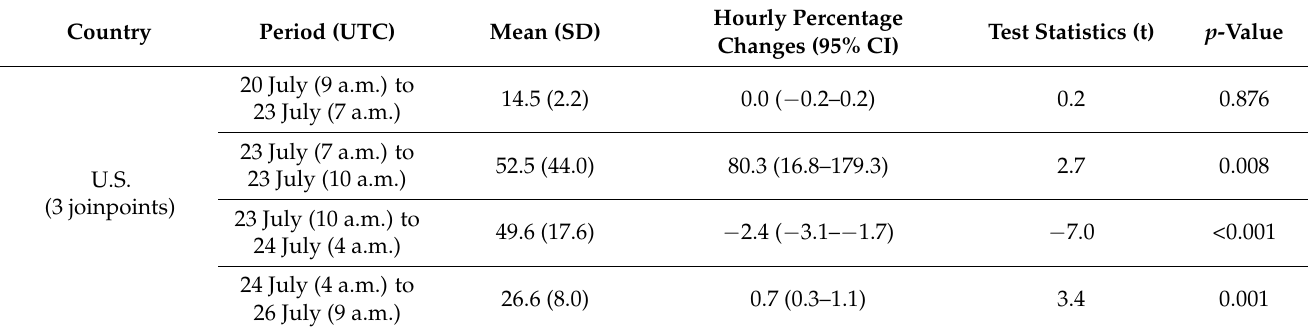
Table 1. Joinpoint regression showing hourly percentage changes in “Monkeypox” relative search volumes on Google Trends—72 h before and just after WHO PHEIC declaration.